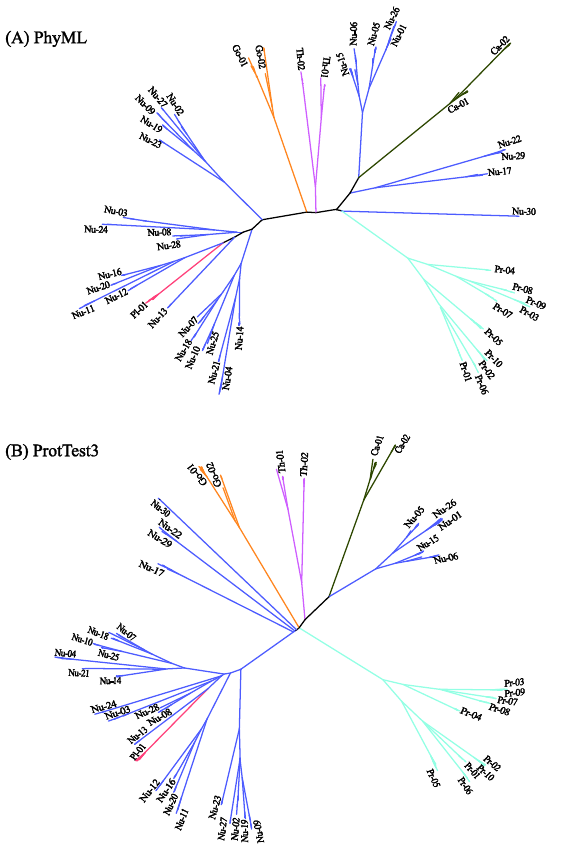
Figure 7. Character-based phylogenetic trees of the GPCR network, as constructed by PhyML using the JTT+R6 model ( A ) and by ProtTest3 using the JTT+I+G+F model ( B ). Each branch is colored ac- cording to GPCRdb’s